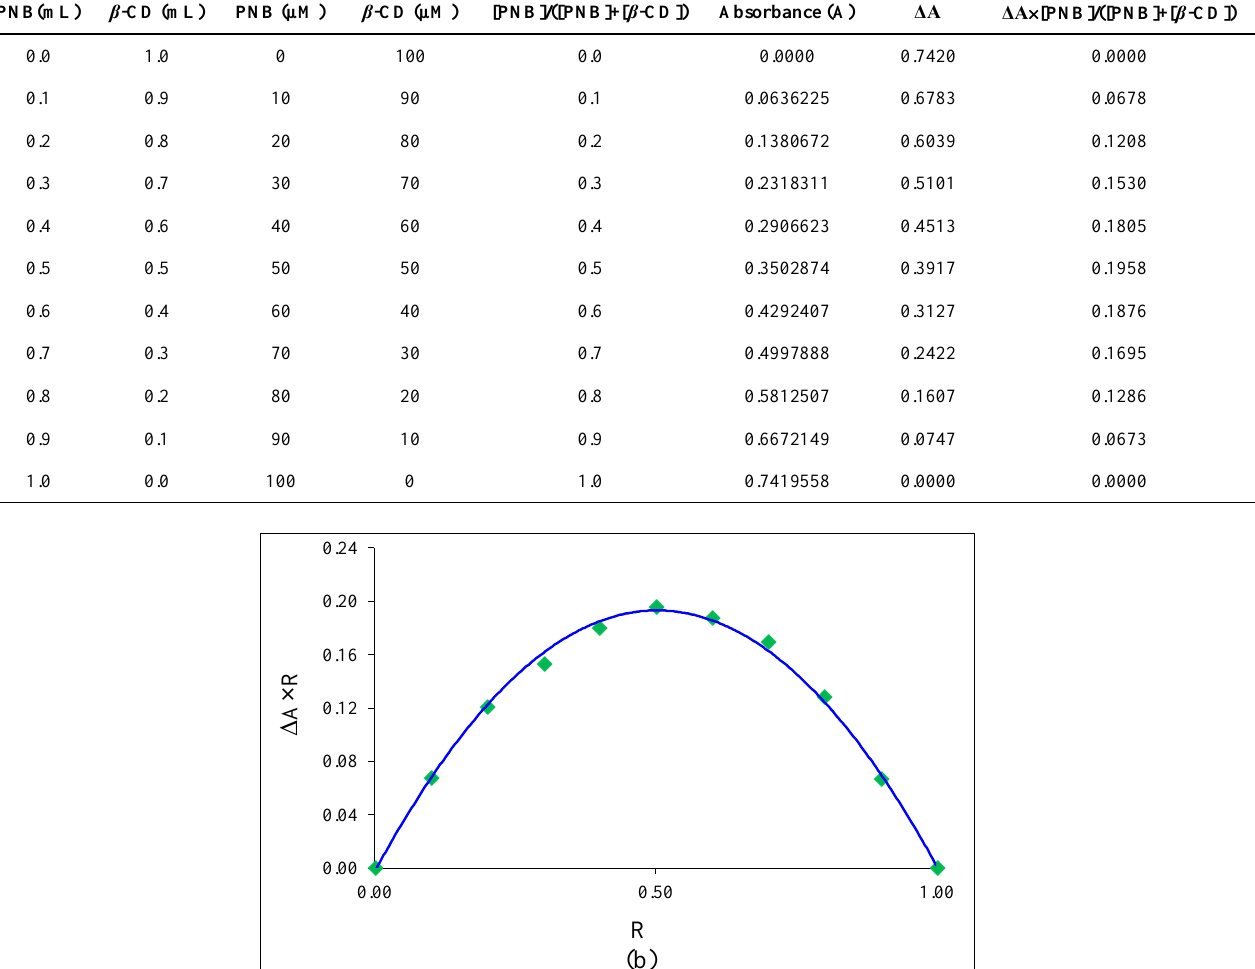
Table 1. Data for the Job plot performed by UV-Vis spectroscopy for PNB- β -CD system at 298.15K a